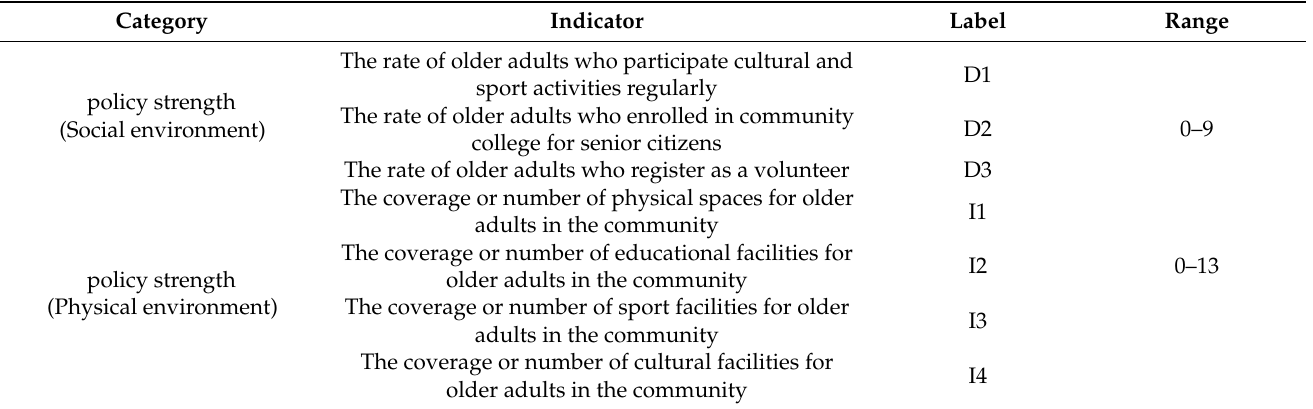
Table 1. Policy strength on AFC in China’s Five-Year Developmental Plan for Population